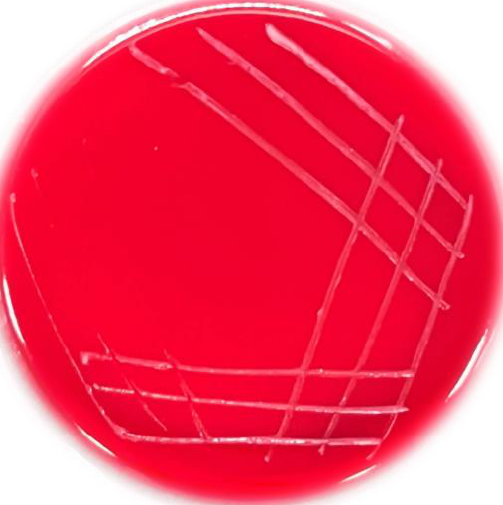
Figure 6. Images of cultures of B. subtilis T5 grown on the blood agar plate after 48 h.